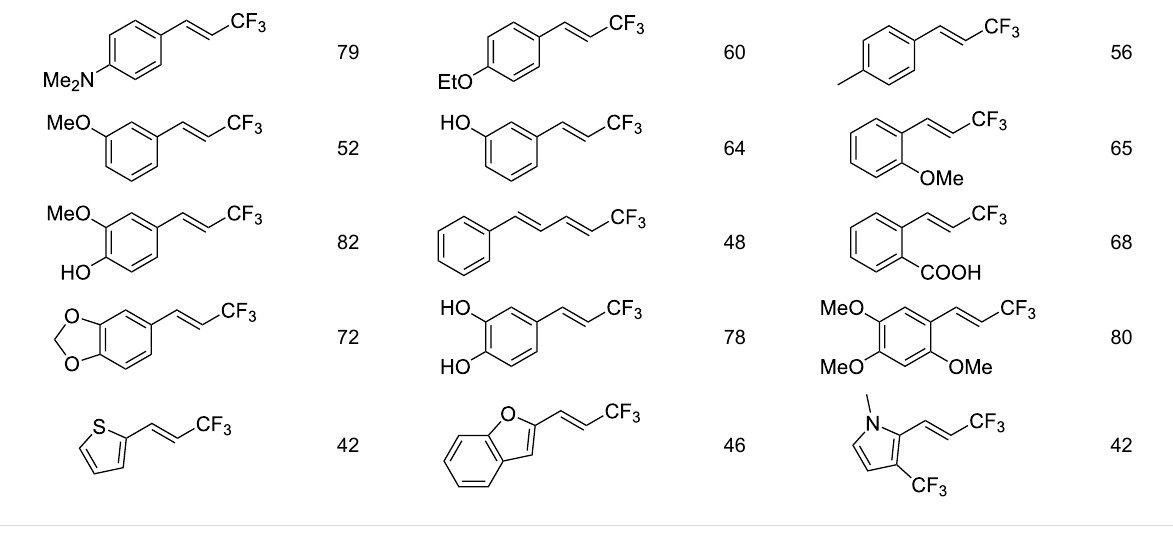
reduced from the former step reacts with the cinnamic acid in the presence of TBHP to afford a cupric cinnamate, which then undergoes the addition of the trifluoromethyl radical to the double bond. The CF 3 -substituted alkene is finally obtained after elimination of carbon dioxide and Cu(I) (Figure